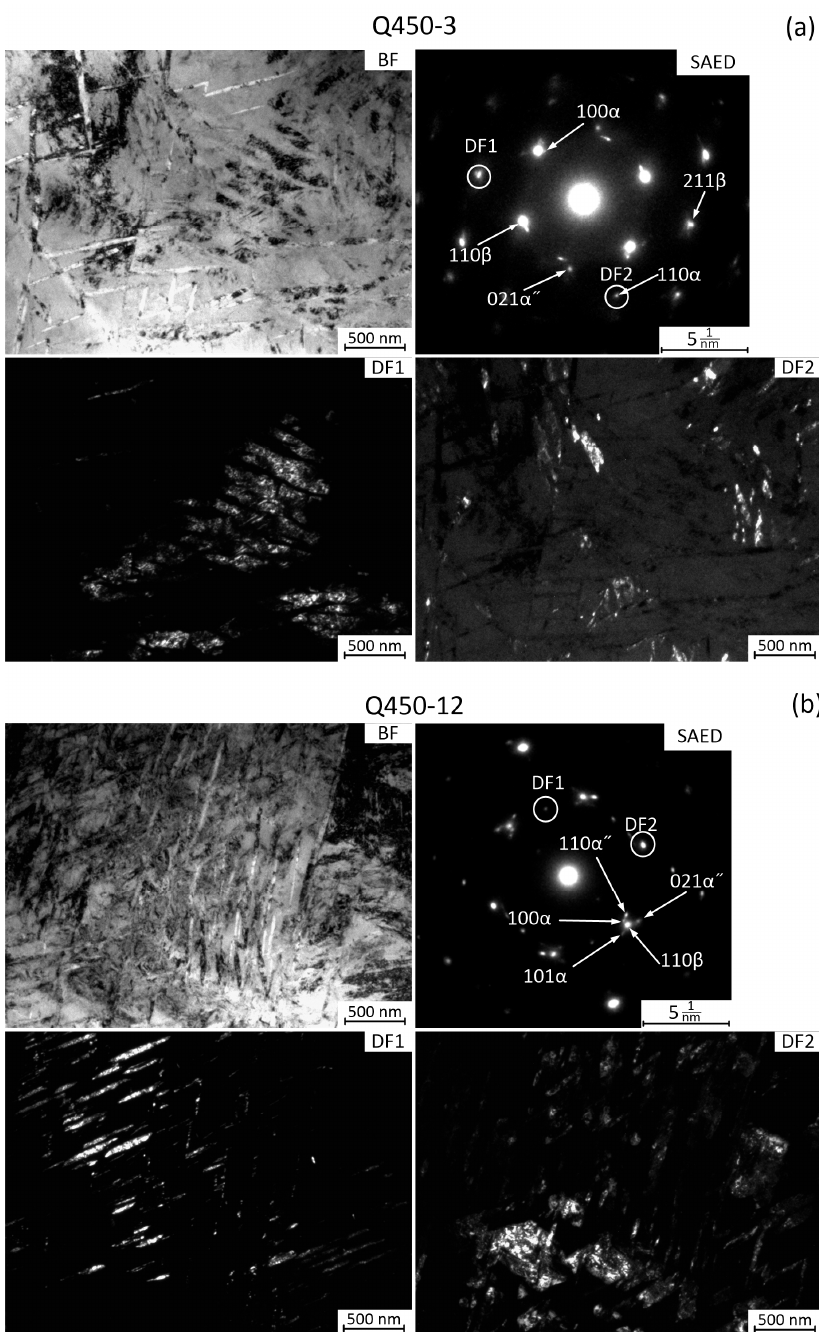
Figure 5. TEM images of the Ti-18Zr-15Nb alloy after: ( a ) Q + 450 °C 3 h; ( b ) Q + 450 °C 12 h. Bright field (BF) and dark field (DF) images, and SAED patterns are shown. Zone axis is close to <110> β . In ( a ), DF1 is taken from an individual 211 β family reflex, while DF2 is taken from an individual 110 α reflex. In ( b ), DF1 is taken from an individual 100 α family reflex, while DF2 is taken from 110 β